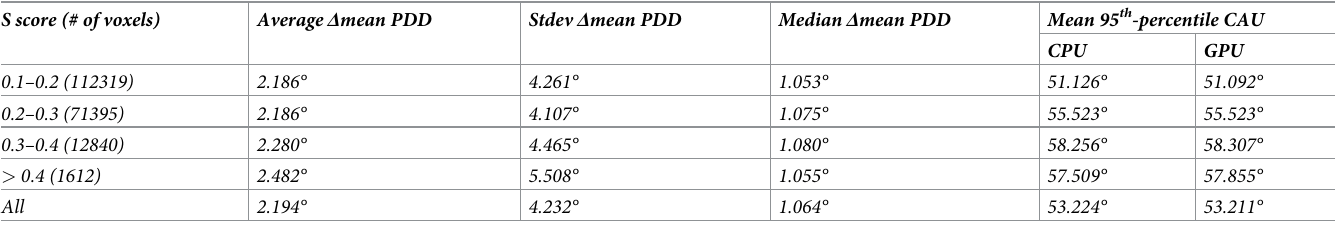
Table 3. Significantly different ϕ 1 , θ 1 .